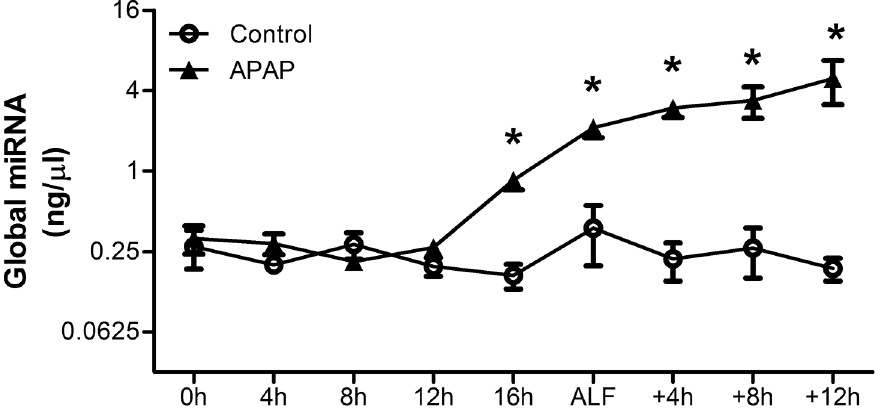
Fig 1. Plasma global miRNA concentrations increase in APAP-treated animals. Plasma global miRNA concentrations were measured every 4h from the onset of dosing until death for APAP-treated pigs (n = 6) and controls (n = 3). Values are means ± SE; * P < 0.05 vs. baseline at